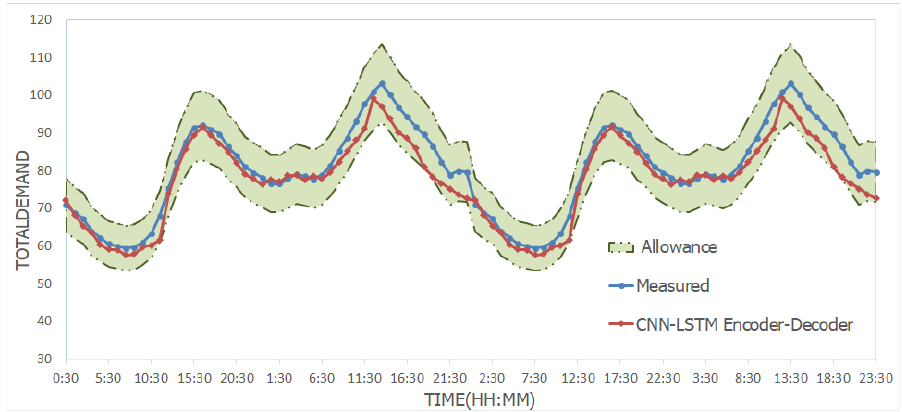
Figure 12. The performance of the CNN-LSTM Auto-encoder in a two-day